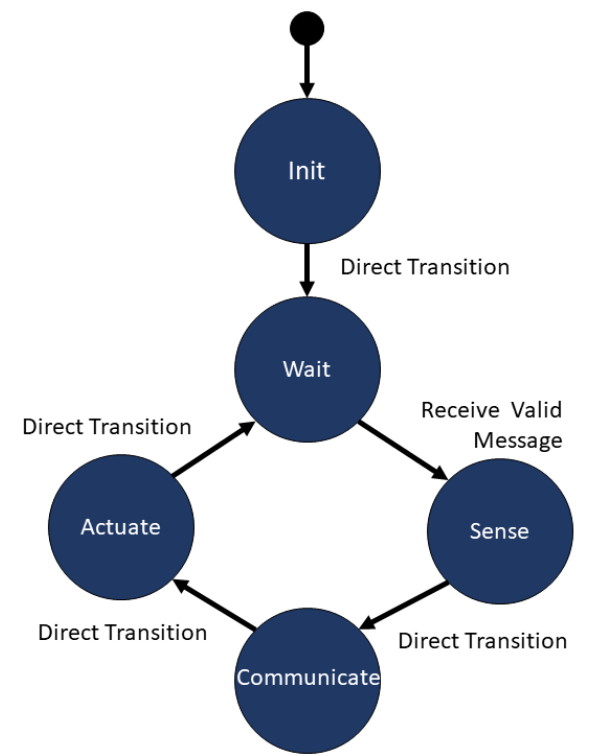
Figure 11. Simple IoT application state